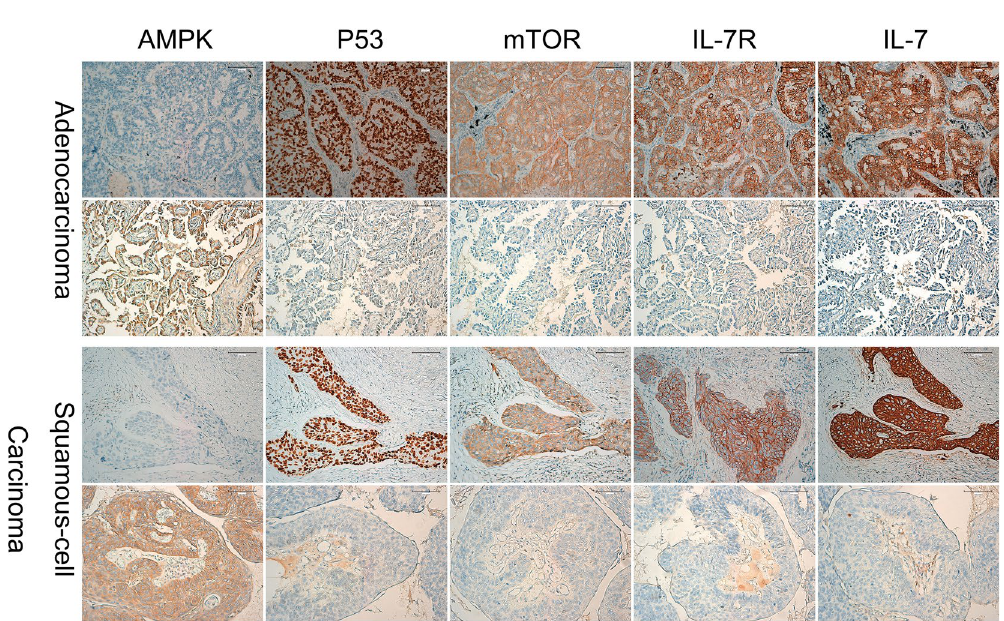
Figure 7. In both adenocarcinoma and squamous-cell carcinoma, AMPK low expression correlates with high expression of P53, mTOR, IL-7 and IL-7R. AMPK high expression associated with low expression of P53, mTOR, IL-7 and IL-7R. Meanwhile, The high expression of P53 was significantly associated with the high expression of IL-7, IL-7R, mTOR, and AMPK low